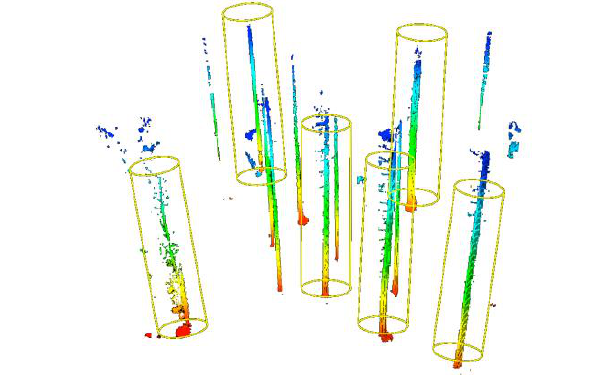
Fig 5. Extracted tree clouds from the study area (cylinders indicate estimated Z-axis direction)